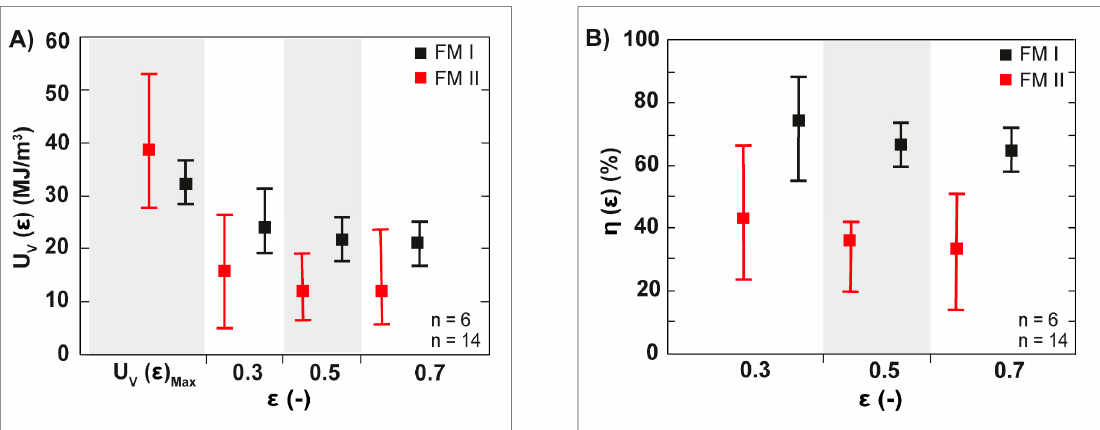
Figure 13. Specific energy absorption per volume unit, U V ( ε ), and the energy efficiency, η ( ε ), of the spine segments of Phyllacanthus imperialis . The relation of the average values of the U V ( ε ) and η ( ε ) to the strain, ε , is displayed in ( A , B ), respectively. FM I: Failure mode I, FM II: Failure mode II.